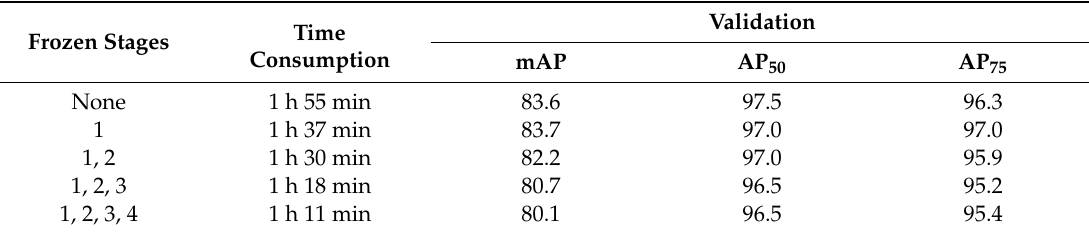
Table 5. Comparison of di ff erent frozen stages in the network on the validation dataset. Frozen Stages